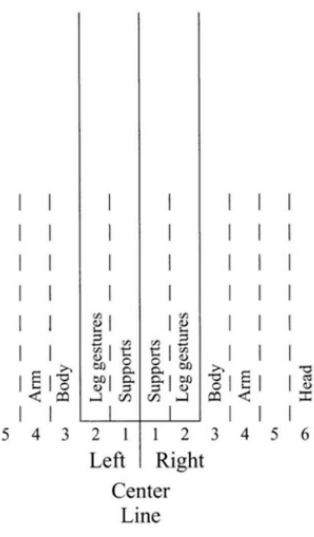
Figure 5. Standard staff of Kinetography. Created by Ann Hutchinson Guest, used with permission from the author.